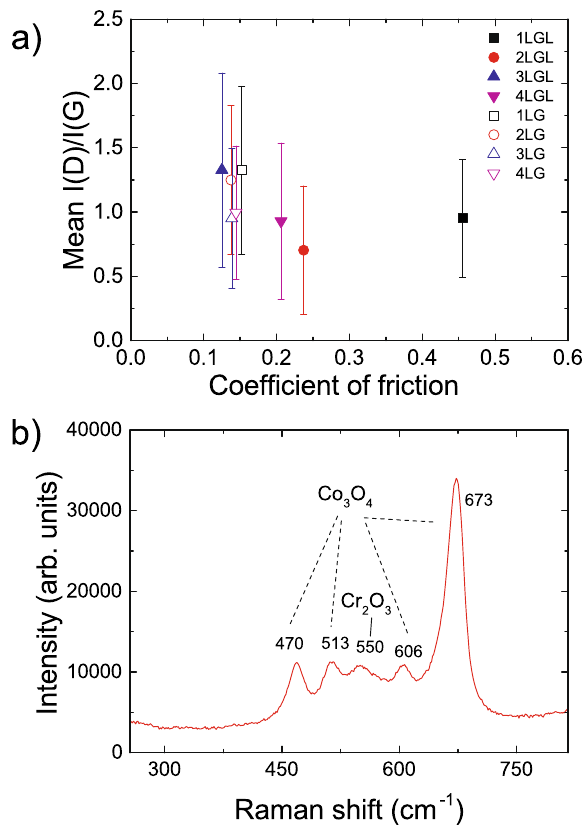
Fig. 7 Raman analysis of defect-induced peaks and hard disk media. a Mean I(D)/I(G) of 1 – 4LG-coated samples, with and without lube, after friction tests, as a function of COF. The error bars come from averaging over the intensity ratios of the peaks in the Raman spectra recorded across the wear tracks. b Raman spectrum on a wear track. The region ~400 – 750cm − 1 shows peaks of the underlying